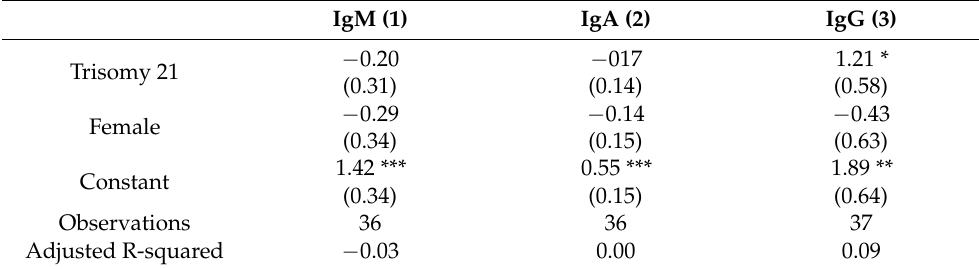
Table 2. MLS Regression on the effects of T21 on Antibody Concentrations.